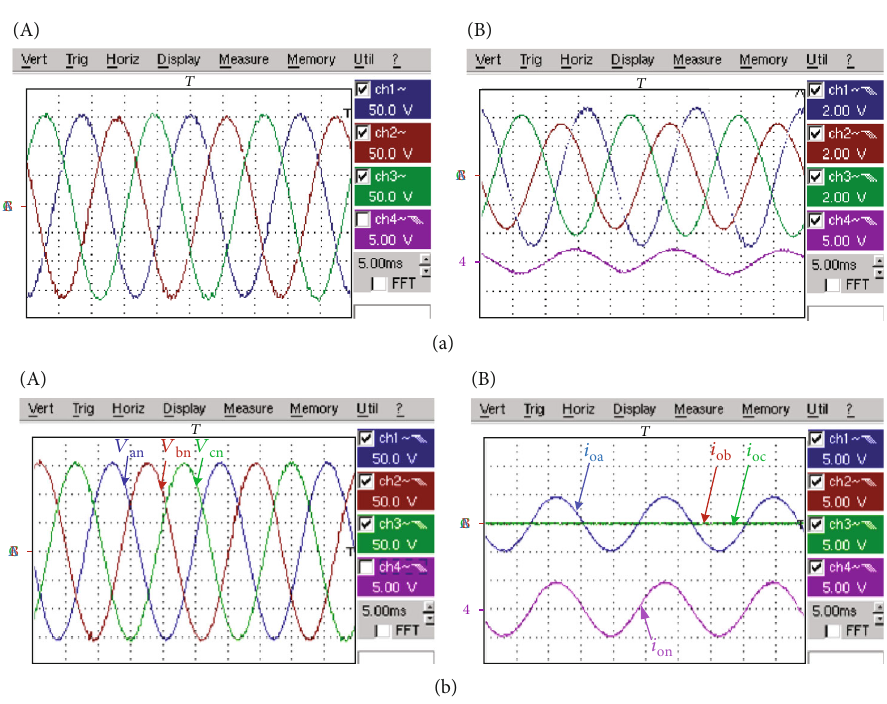
Figure 7: The experimental results of proposed hybrid controller under unbalanced condition: (a) Two-phase voltage generation and (b) single-phase load condition; A: load phase voltages (ch1-ch3(50V/div)) and B: load and neutral currents (13 A/div).